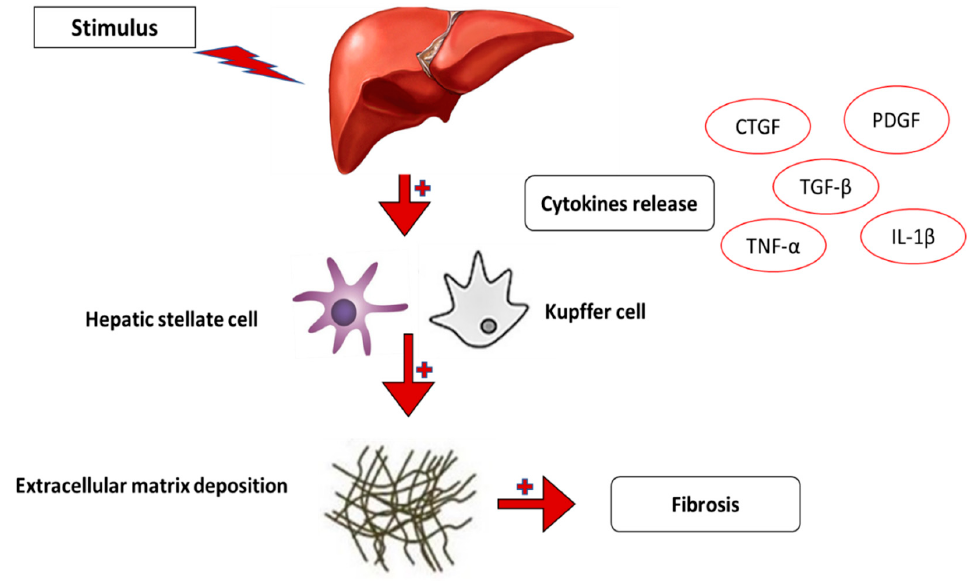
Figure 14. Liver fibrosis results from changes in cytokine release such as connective tissue growth factor (CTGF), transforming growth factor-beta (TGF- β ), platelet-derived growth factor (PDGF), tumor necrosis factor-alpha (TNF- α ), and the accumulation of extracellular matrix deposition.